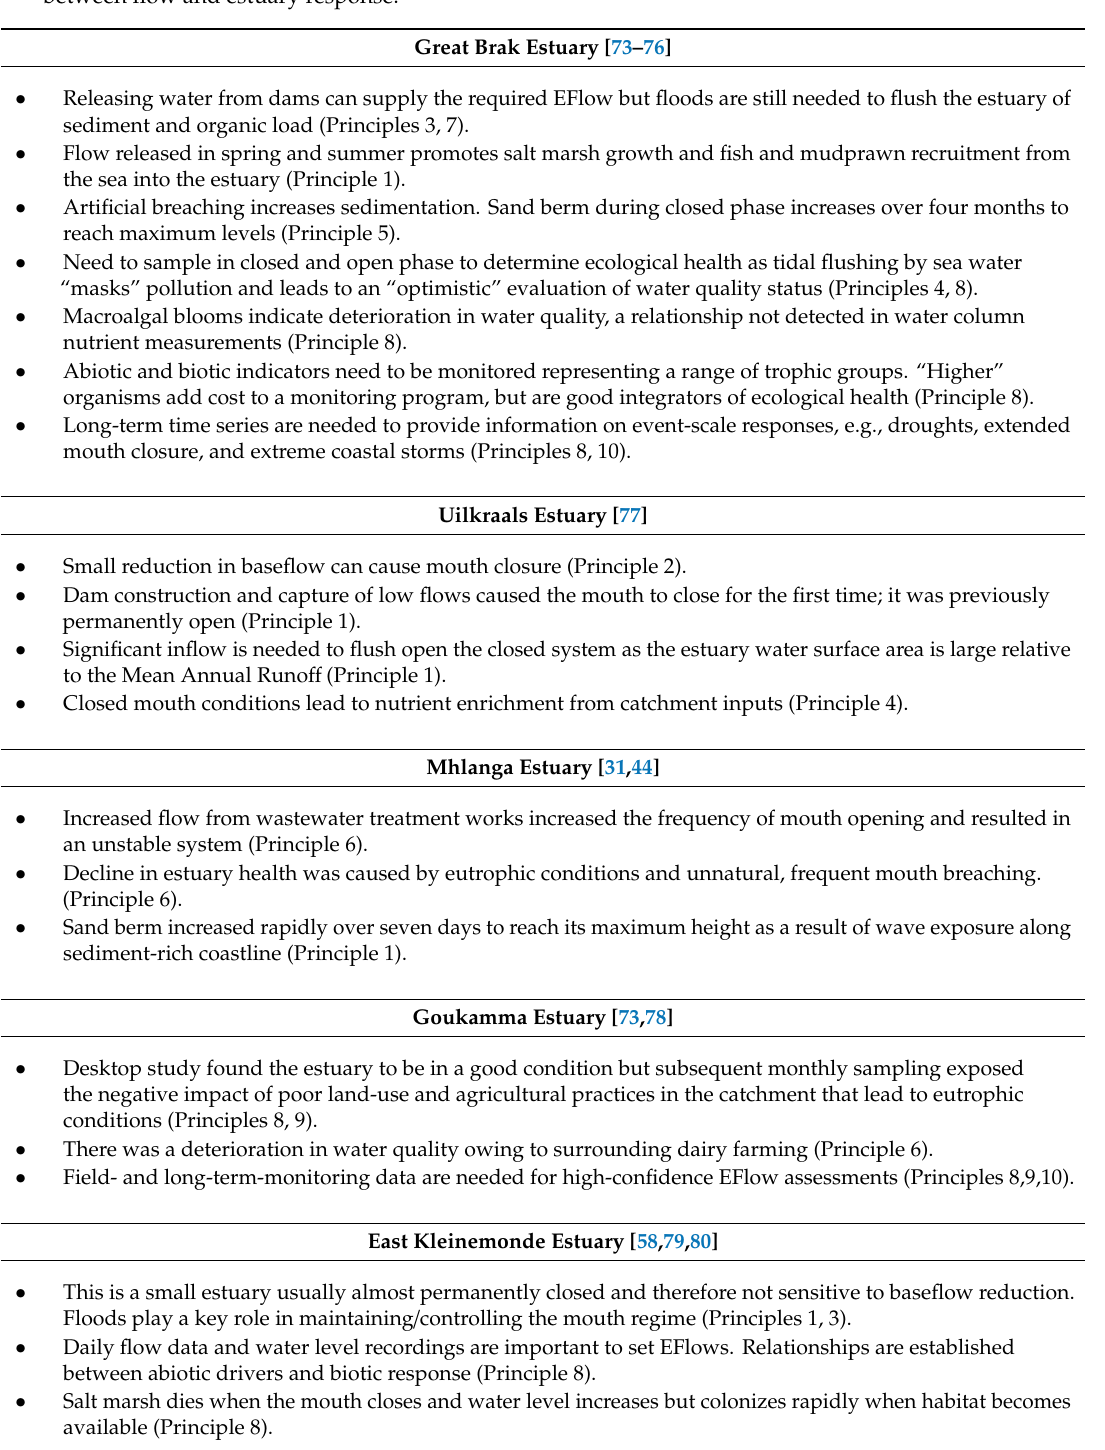
Table 3. Key lessons from EFlow case studies that advanced the understanding of the relationship between flow and estuary